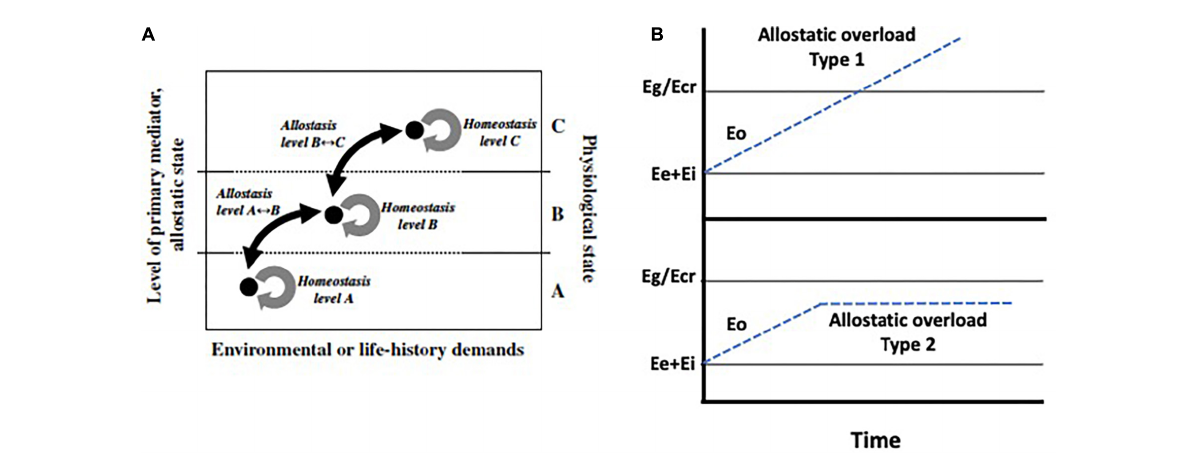
FIGURE1 (A) An explanation of the terms: “homeostasis,” “allostasis,” and “physiological state.” Action of primary mediators (i.e., action of hormones, elements of the immune system, and/or neural responses; defined as an allostatic state) tune critical internal variables to specific set points as appropriate to existing environmental conditions and life-history demands (McEwen and Wingfield, 2003). “Allostasis” is defined as the process of adjusting critical internal variables among such set points. In contrast, we refer to “homeostasis” as the process of maintaining internal variables within a given set point. The physiological and behavioral characteristics of a specific set point can be described by three increasingly complex physiological states – A, B, and C. Physiological state A is characterized by basic physiological and behavioral processes fundamental for simple existence. Physiological state B is representative of processes associated with increased, but predictable or manageable demands in the environment or in life history. Physiological state C is characterized by facultative responses (e.g., the emergency life-history stage) associated with unpredictable and life-threatening events. The physiological states A, B, and C are paralleled by allostatic states that maintain processes at given set points through the action of primary mediators. From Landys et al. (2006) with permission, Elsevier. (B) A schematic representation of energy available to obtain in the habitat ( E g ) or total resources including stored fat ( E cr ), existence energy ( E e ) and energy required to go about daily routines (E1). E o (dashed blue line) is the additional energy resulting from a perturbation or changed weather conditions that increases allostatic load (for example increased foraging effort). Allostatic overload type 1 occurs when E e + E i + E o exceeds E g / E cr precipitating negative energy balance (top panel) and triggers the emergency life history stage (ELHS). In the bottom panel, E o increases and remains permanently elevated but below E g / E cr . This is allostatic overload type